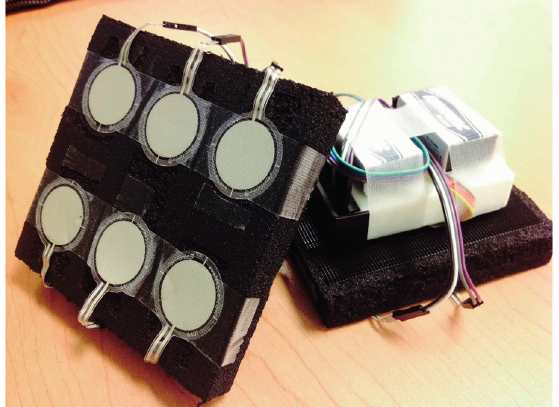
Figure 1. Front and back of one sensor array, showing Tekscan’s FlexiForce ® Standard Force & Load Sensors Model A401-25. Dimensions: 11.5 × 11 × 2 cm for shins; 12 × 11.5 × 2 cm. for thighs. Approximate weight with batteries: 190